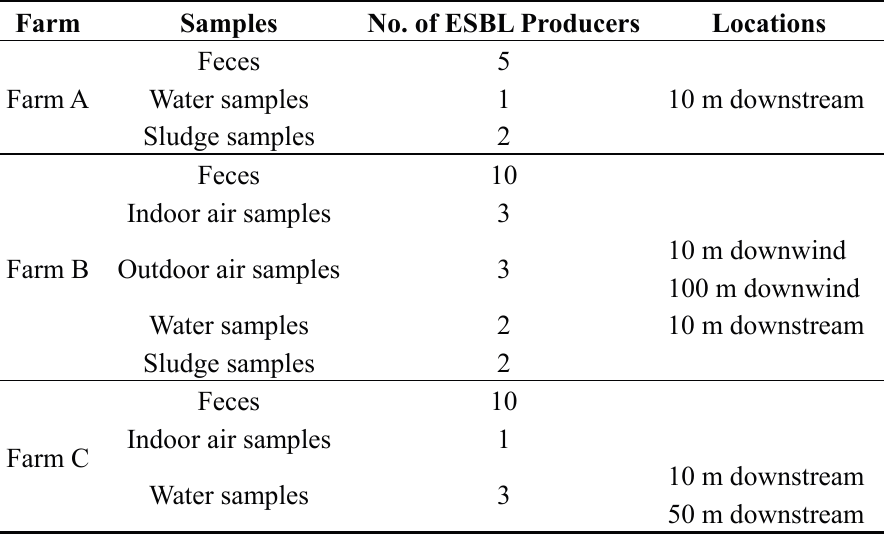
Table 2. No. of 119 ESBL-producing E. coli and their locations. Farm